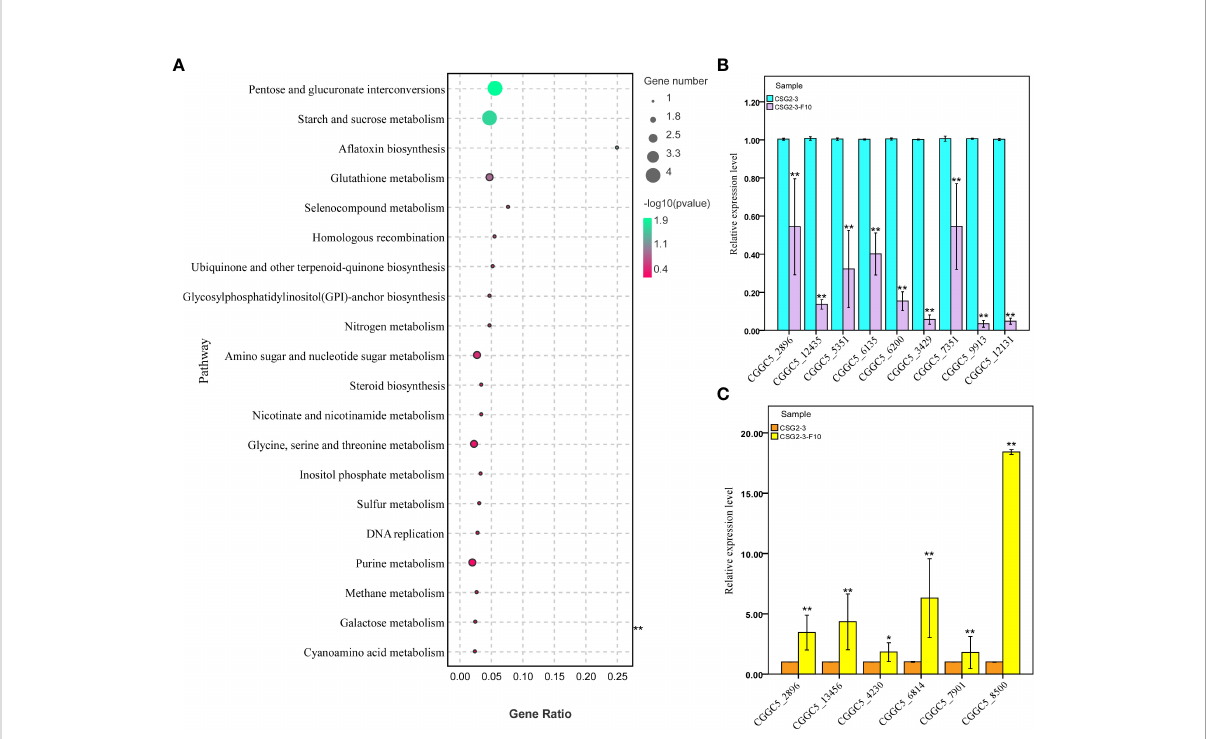
FIGURE 8 KEGG enrichment analysis and RT-qPCR veri fi cation of DEGs between CSG2-3 and CSG2-3-F10. (A) The bubble graph displays KEGG items on the Y-axis and rich factors on the X-axis. The color of bubbles represents the P value. The size of bubbles represents the number of genes. (B, C) The expression of fi fteen DEGs (nine downregulated and six upregulated DEGs) was examined via RT-qPCR. Biological and technical replicates were performed for each RT-qPCR. The asterisk represents a signi fi cant difference (Student ’ s t -test, ‘ ** ’ , P<0.01, ‘ * ’ ,